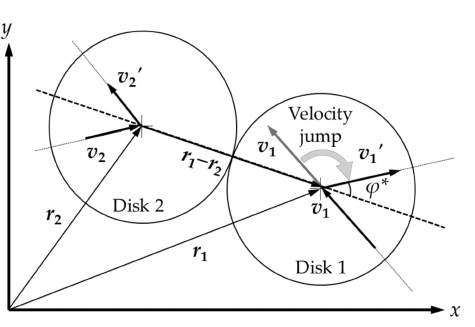
Figure 2. Two disk-shaped solids elastically colliding with each other in the x - y